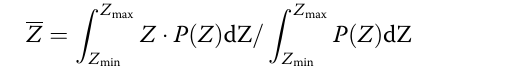
Table 3 Estimated interval of the weight of the